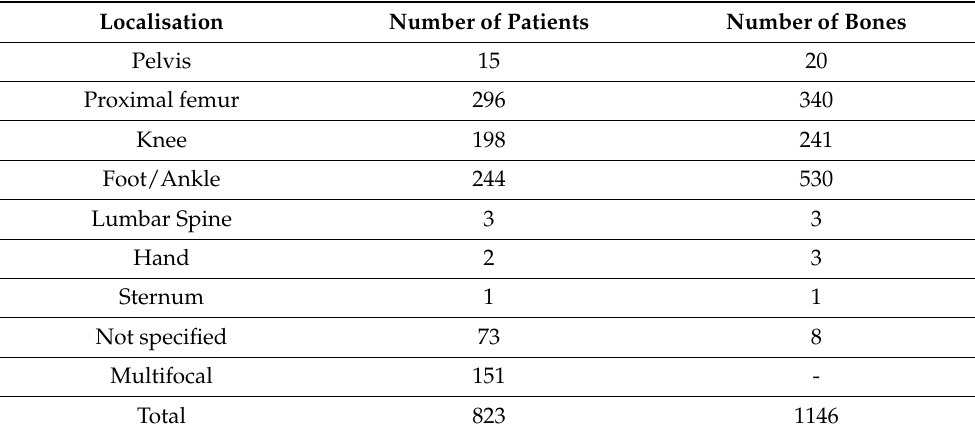
Table 1. Localization of the bone marrow edema, total number of patients und number of bones.